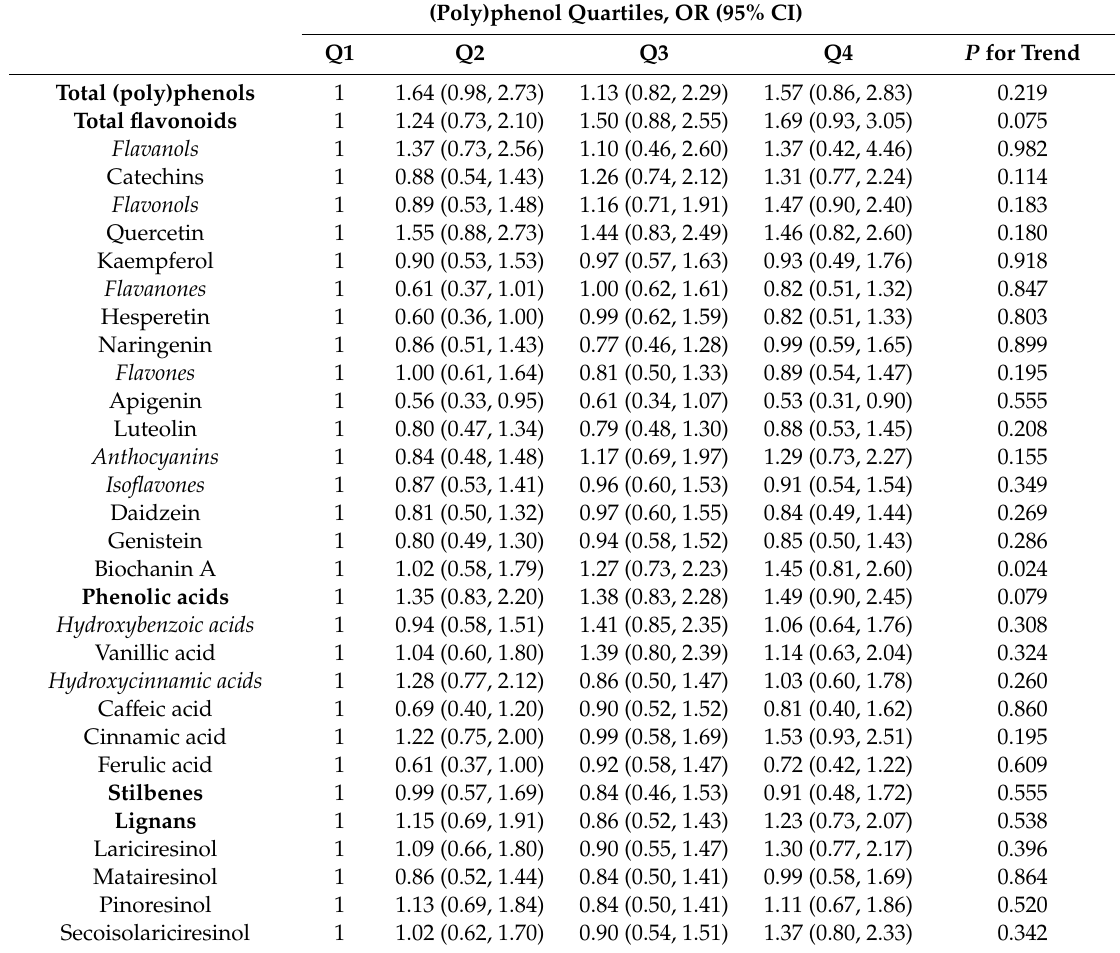
Table 4. Odds ratios (ORs) and 95% confidence intervals (CIs) for the associations between (poly)phenol intake (total, main classes, subclasses and individual compounds) and adequate sleep quality in overweight / obese